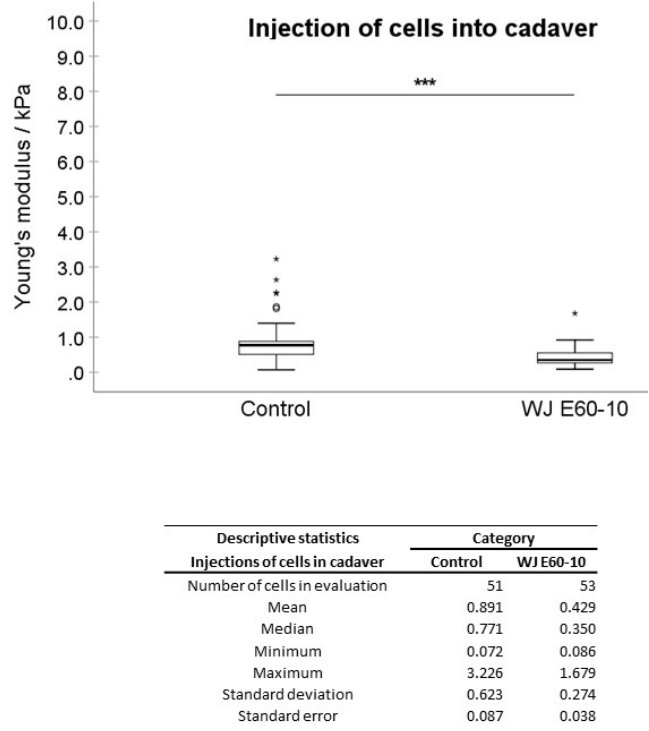
Figure 6. Analysis of Young’s modulus of cell injections by WJ in tissue. Boxplots (medians, minimum, maximum) of the stiffness (kPa) measured by atomic force microscopy for controls and WJ-injected pADSCs in fresh porcine cadaveric tissue are depicted. The control (untreated) cell monolayers revealed a higher stiffness when compared to the WJ group. Descriptive statistics of Young’s moduli in control and WJ-injected cells in fresh porcine cadaveric tissue. Medians with minimum and maximum, means, standard deviations and standard errors of the mean of both groups are depicted. *** p < 0.001. Abbreviations: WJ—waterjet.